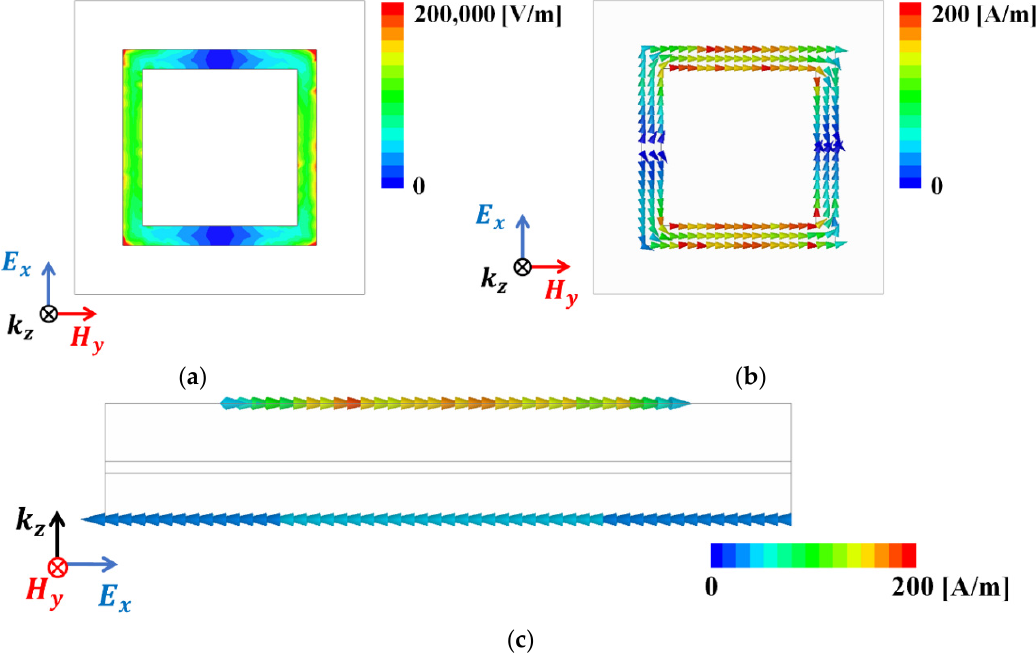
Figure 4. ( a ) Simulated electric field distribution: ( b ) top view and ( c ) side view of the vector current density at 27.7 GHz on the proposed metamaterial absorber.